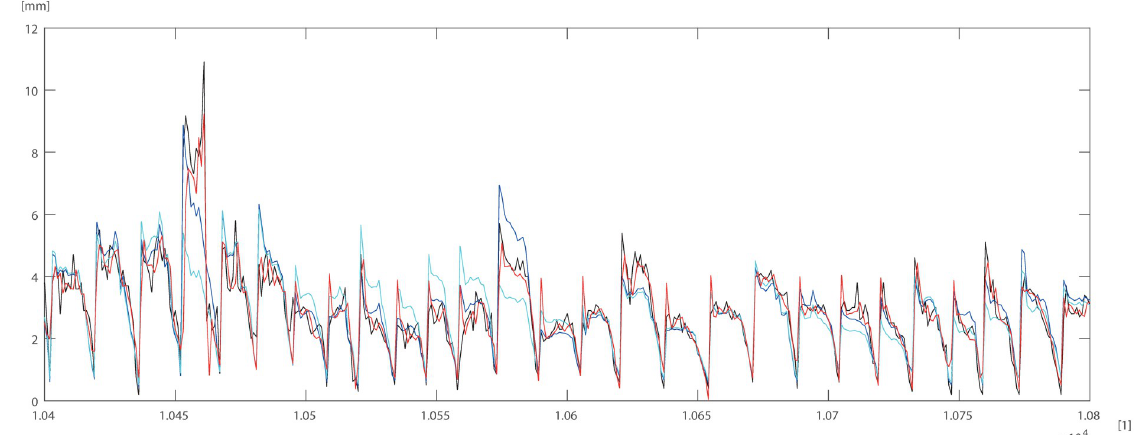
Fig 7. First 60 DBT data (black line), STAT 2 (blue line), STAT 1 (cyan line), ANN (red line) for pine. Horizontal axis [1]—identifier of measurement.